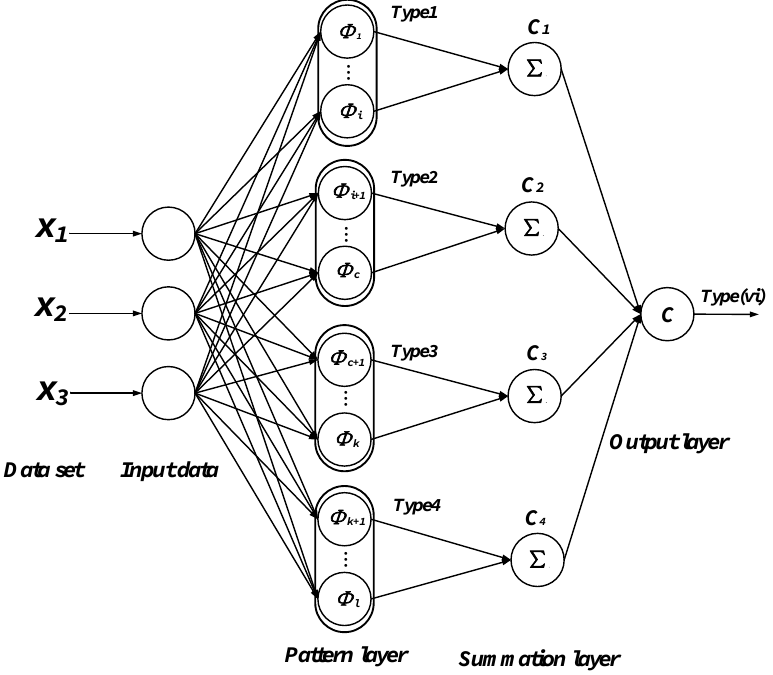
Figure 1. Probabilistic neural network structure